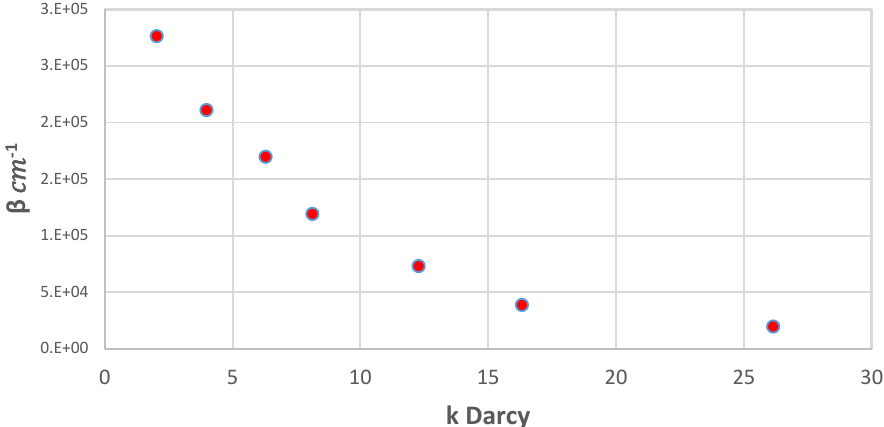
Figure 8. The effect of permeability inertia coefficient β . It can be seen from Figure 9 that the non-Darcy coefficient decreases with the increase of median pore diameter. The non-Darcy coefficient decreases slowly in the bigger pore diameters, and that is because the flow cross-section area is larger in the porous media with a large pore.